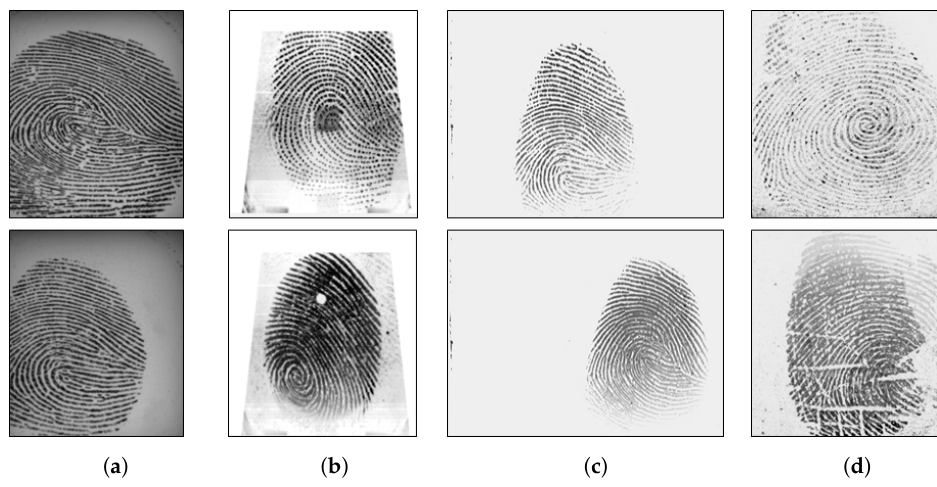
Figure 6. Sample images of LivDet 2011. The top row includes live samples; the bottom row includes fake samples. Samples are from Biometrika ( a ), Digital Persona ( b ), ItalData ( c ) and Sagem ( d )